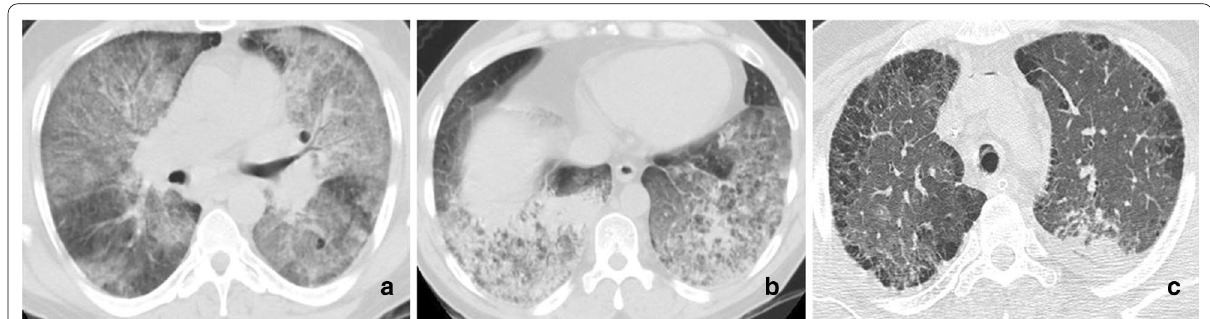
Fig. 6 Acute interstitial pneumonia mimicking typical COVID‑19 in a 48‑year‑old man presented with symptoms simulating ARDS. a , b axial CT images show bilateral extensive diffuse GGO and few areas of consolidation with interlobular and intralobular septal thickening, and mild bronchial dilatation. Transbronchial biopsy showed features of diffuse alveolar damage. c Follow‑up axial CT image shows after one month shows subpleural honeycombing, fibrotic bands and traction